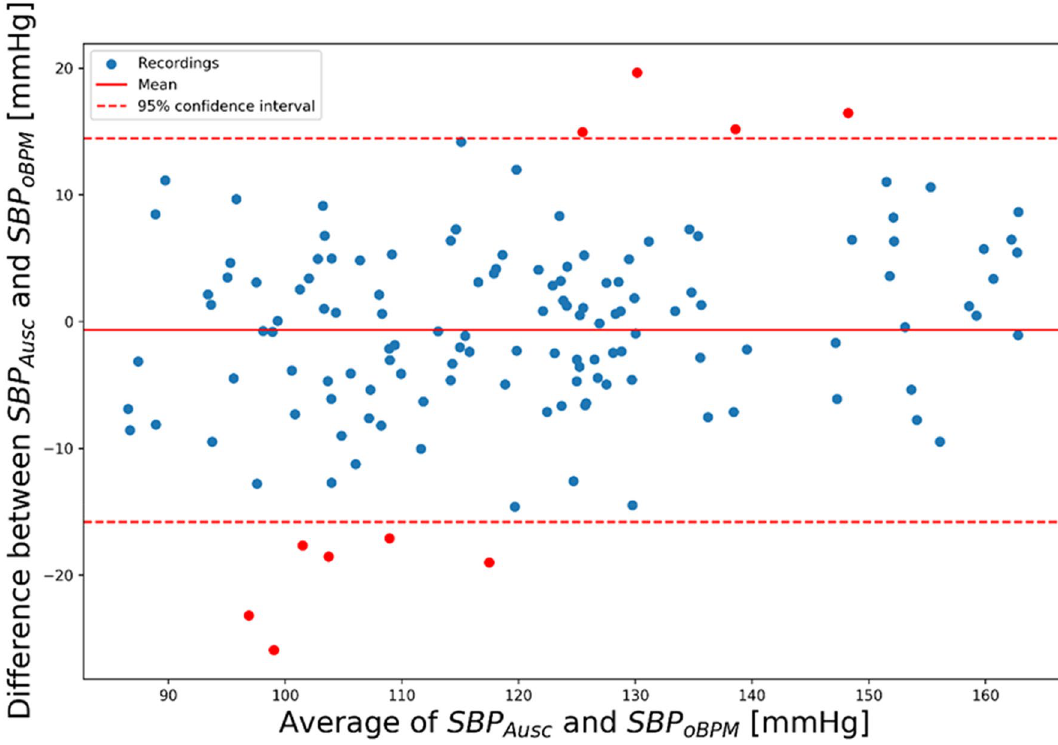
Figure 4. Standardized Bland–Altman scatterplots depicting the agreement between the OptiBP smartphone app systolic estimates assessed by the oBPM algorithm (SBP oBPM ) and the auscultatory-derived reference systolic BP measurements (SBP Ausc